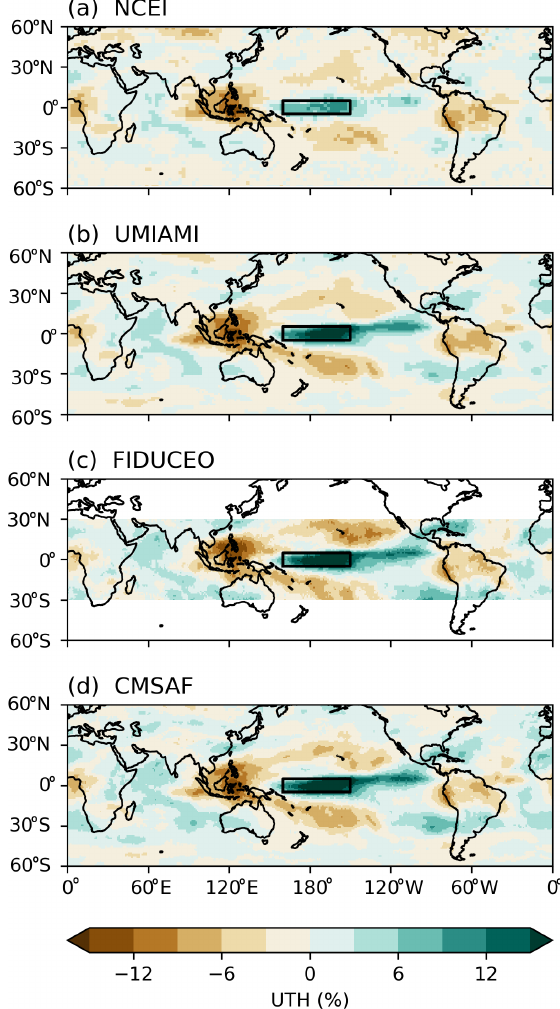
Figure 5. Anomalies of UTH during the peak 6 months of the 2015– 2016 El Niño event. The box shows the Niño 4 domain in the central Pacific (5 ◦ S–5 ◦ N, 160 ◦ E–150 ◦ W).